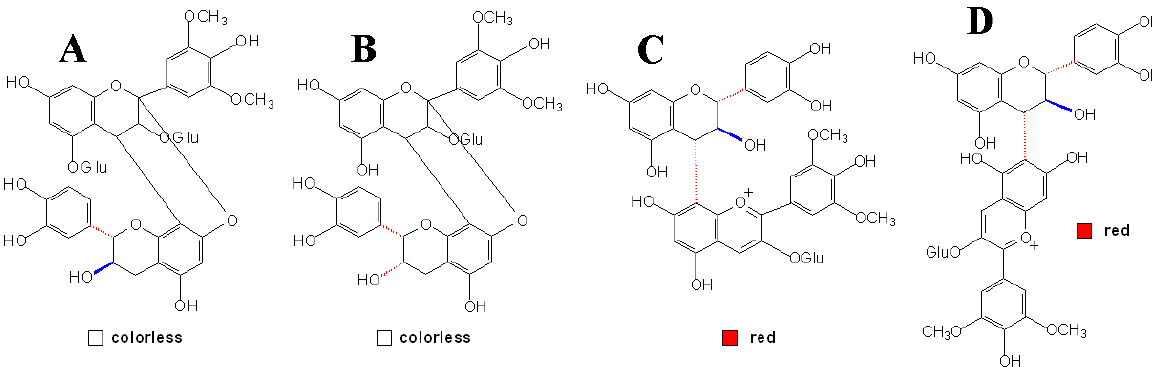
Figure 1. Structures of the condensed products of anthocyanin and flavan-3-ols [57-58,